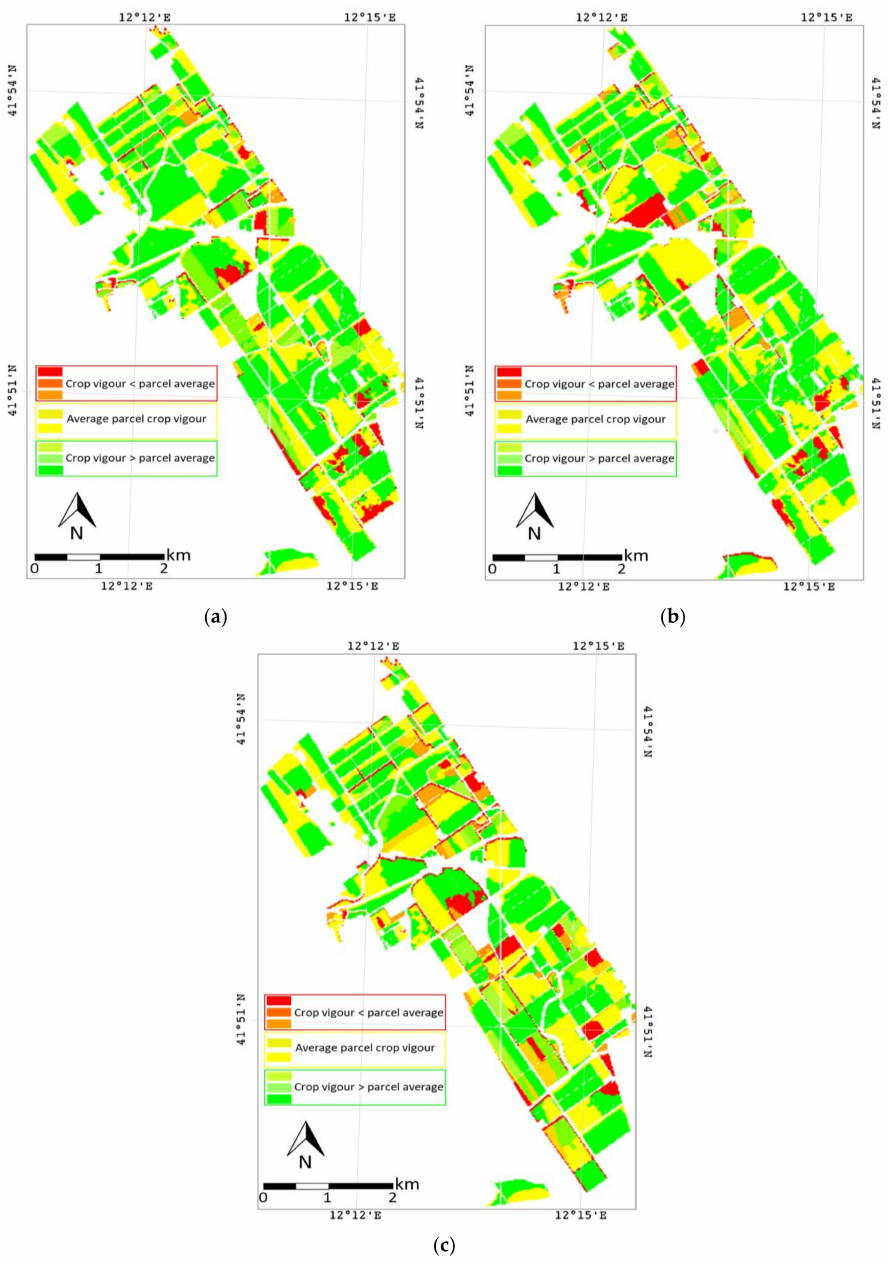
Figure 4. ( a ) MFK; ( b ) FPCA; and ( c ) MK clustering maps showing the results obtained for the 94